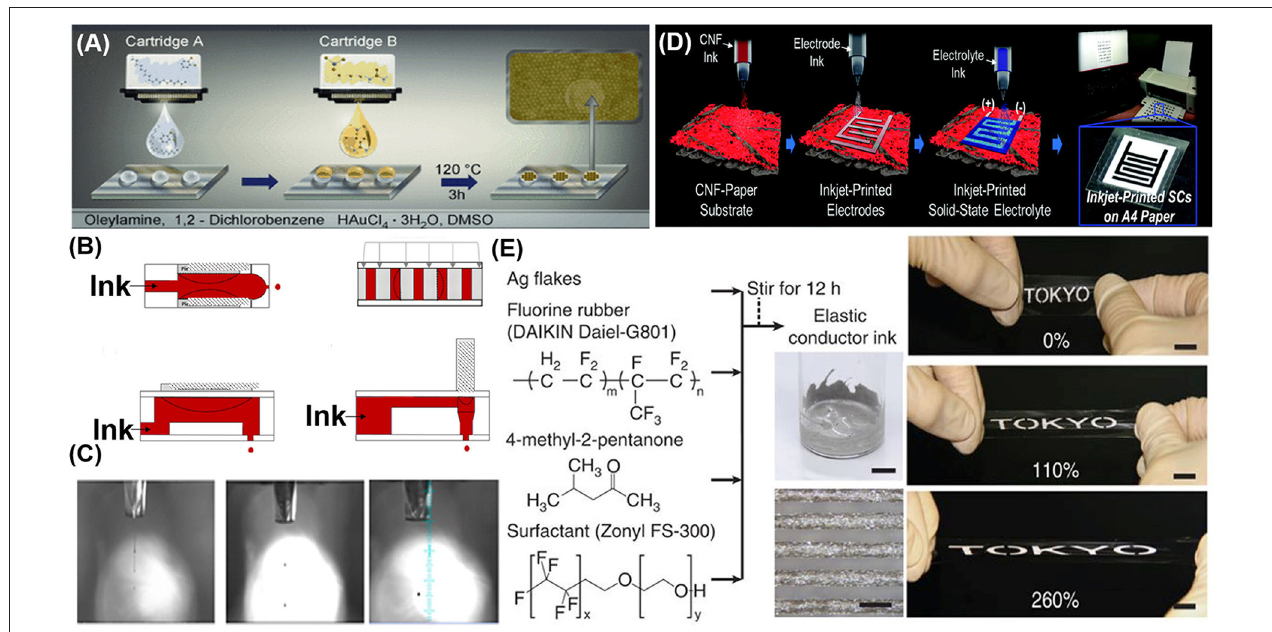
FIGURE 7 | (A) In situ synthesis of the Au nanoparticle in ink printing (Abulikemu et al., 2014). Reproduced with the permission of 1999–2018 John Wiley & Sons. (B) Four types of piezoelectric inkjet nozzles (Eshkalak et al., 2017). Reproduced with the permission of 2018 Elsevier B.V. (C) Drop ejection of the ink (Dankoco et al., 2016 ). Reproduced with the permission of 2018 Elsevier B.V. (D) Fabrication of supercapacitors with the inkjet printing technique (Choi et al., 2016). Reproduced with the permission of 2016 Royal Society of Chemistry. (E) Fabrication process of elastic ink and printed elastic patterns under a tensile force ( Matsuhisa et al., 2015). Reproduced with the permission of 2015 Macmillan Publishers